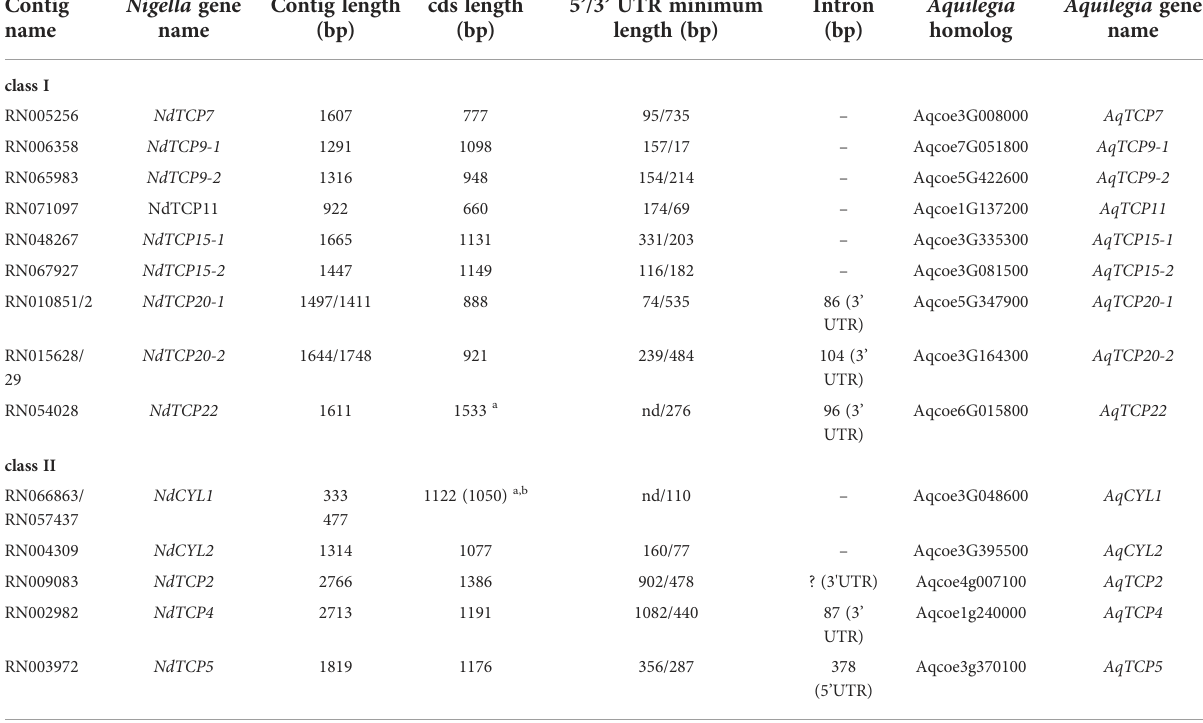
TABLE 1 Characteristics of TCP sequences in Nigella damascena , and their homologs in Aquilegia coerulea